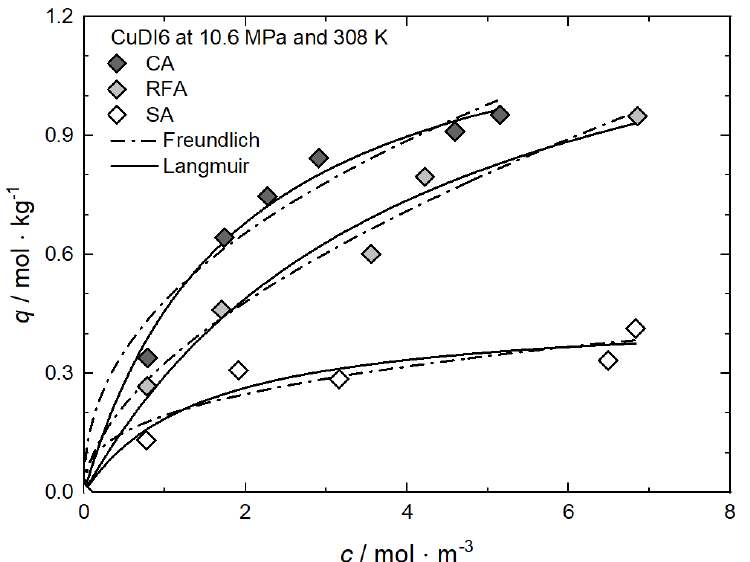
Figure 13. Uptake of CuDI6 at 10.6 MPa and 308 K on different substrates; experimental data taken from [61]. Table 10. Adsorption isotherm parameters for CuDI6 from scCO 2 solution at 10.6 MPa and 308 K on different substrates [61].